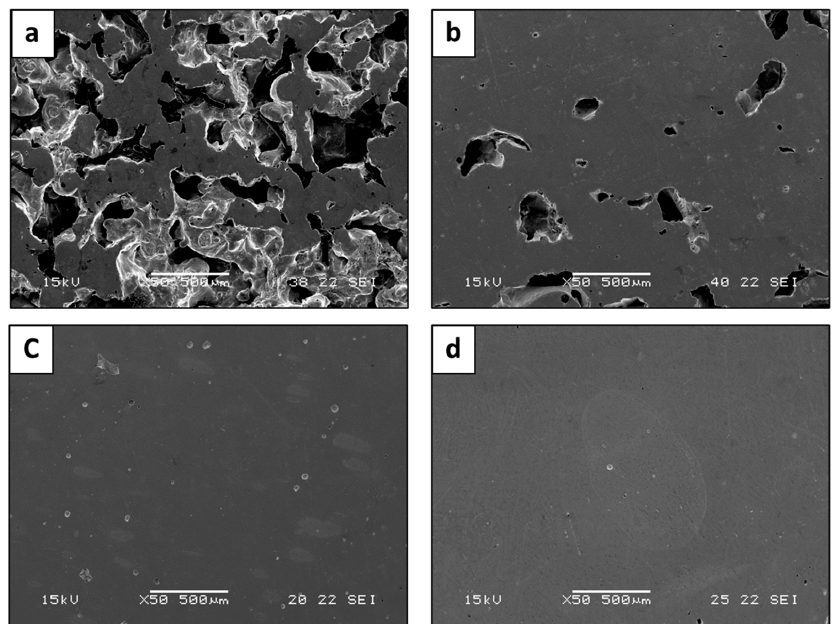
Figure 2. Macroscopic structure of HEA WTaMoNbV obtained by various LPBF trials and AMF processes: ( a ) LPBF—Primary trials, ( b ) LPBF—Intermediate trials, ( c ) LPBF—Advanced trials, ( d ) counterpart alloy obtained by AMF process.